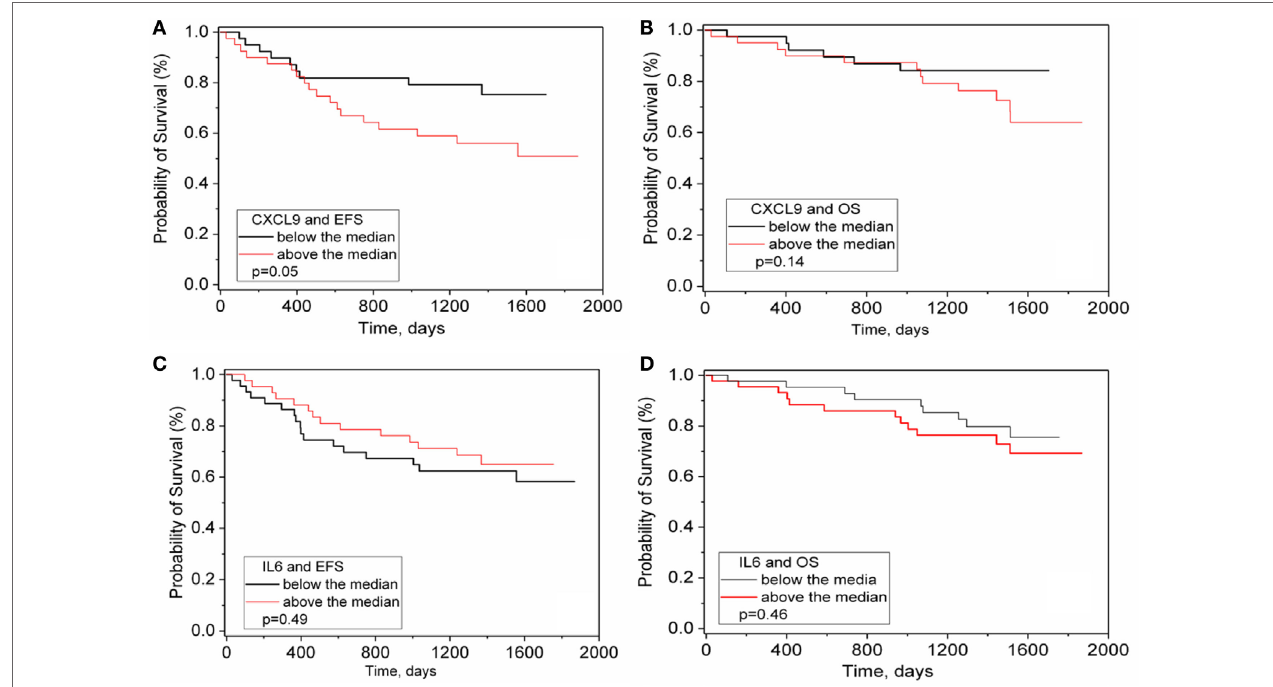
FiGUrE 4 | CXCL9 and IL-6 versus survival in immunotherapy treated patients. CXCL9 (a,B) and IL-6 (C,D) were measured in the serum of ANBL0931 patient samples obtained at pretreatment to course 1. Patient values were sorted as to above or below median levels of all patients and a Kaplan Meier survival analysis for event-free survival (a,C) and OS (B,D) assessed and significance assessed by Log Rank